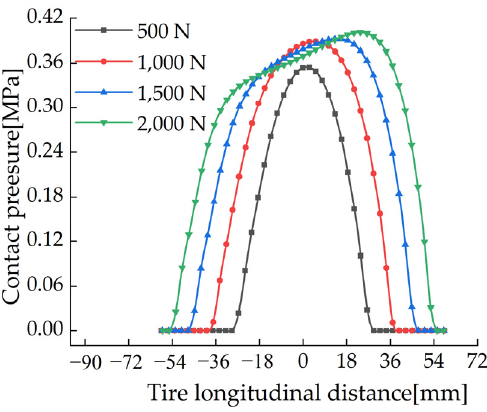
Figure 15. Contact pressure distribution of tire longitudinal contact patch under different loads.